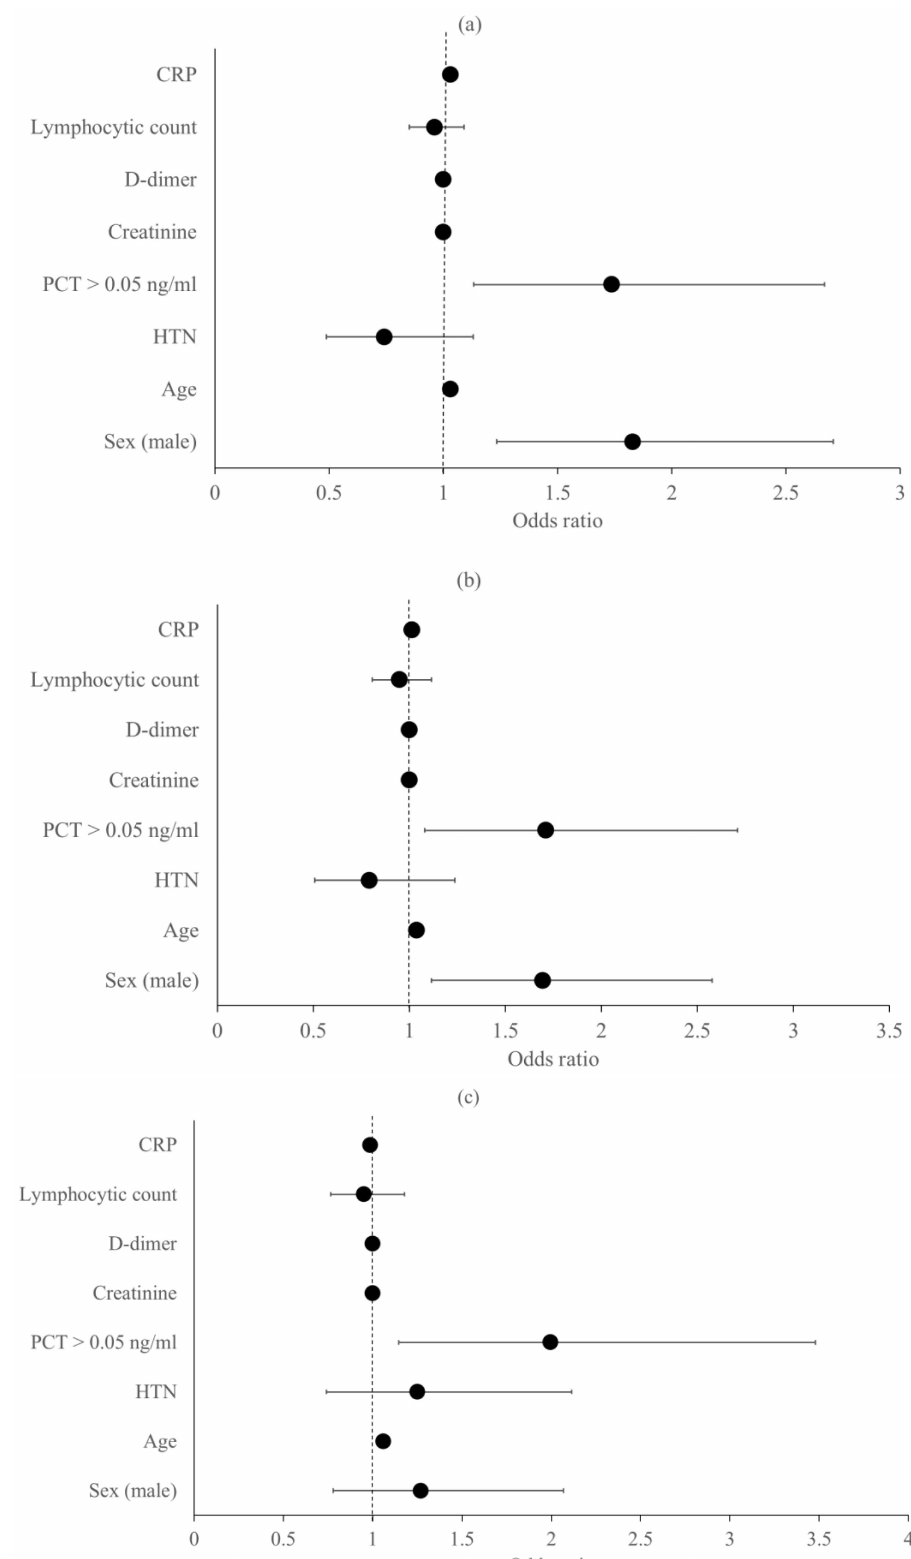
Figure 3. Risk factors for the main primary outcomes: ( a ) ICU admission, ( b ) IMV, and ( c ) Hospital mortality. For each variable, the black dot represents the odds ratio, and the horizontal line represents the 95% confidence interval. Abbreviations: CRP, C-reactive protein; PCT, procalcitonin; HTN, hypertension; ICU, intensive care unit; IMV, invasive mechanical